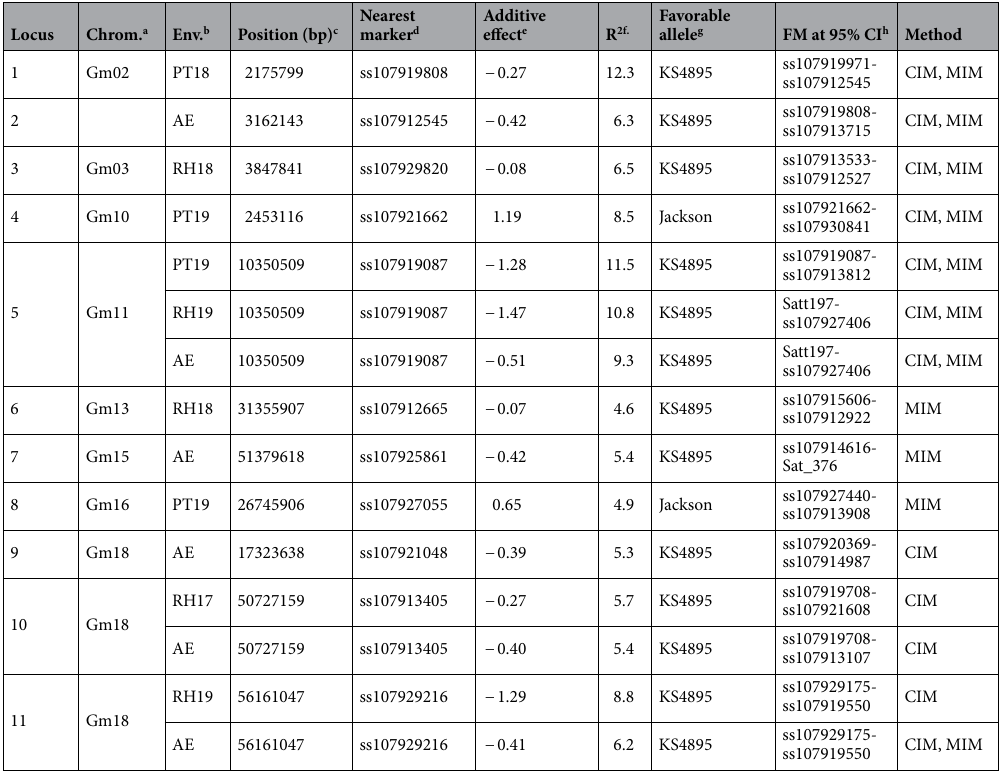
Table 3. The QTLs associated with canopy temperature identified by composite interval mapping (CIM) and multiple interval mapping (MIM) in a RIL population of KS4895 and Jackson which were evaluated at Pine Tree and Rohwer in 2017, 2018, and 2019. a Glycine max chromosome on which QTL was present. b Environment in which specific QTL was identified. Prefixes PT and RH denotes Pine Tree and Rohwer, respectively followed by 17 (2017), 18 (2018), and 19 (2019) for years. AE denotes averaged across environments. c QTL position in base pairs on respective chromosomes according to Glycine max